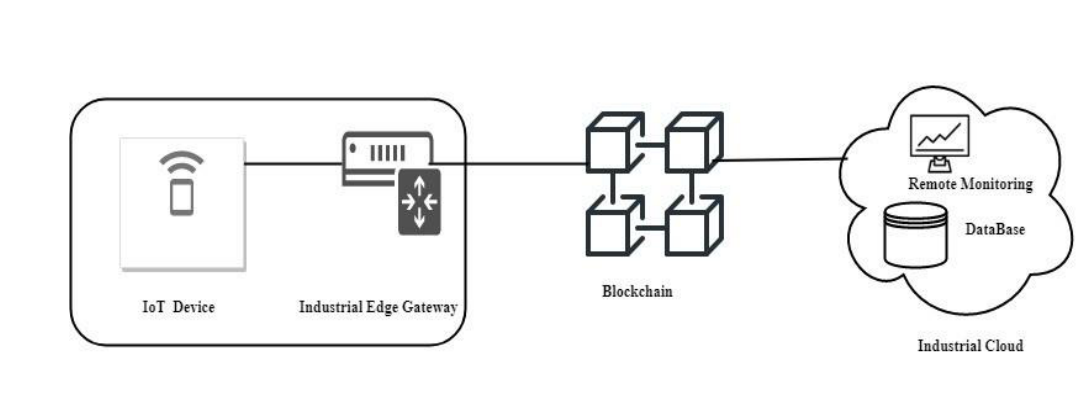
Figure 16. BIoT based industrial cloud.